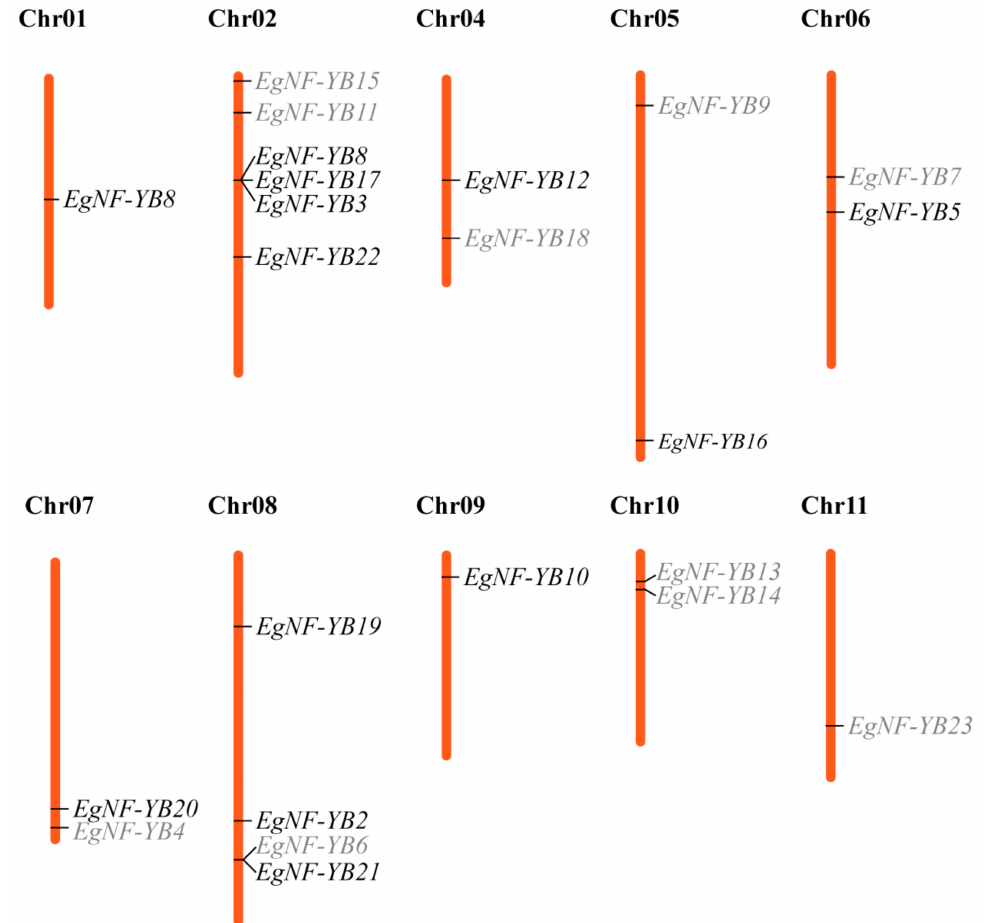
Figure 5. Chromosomal localization of EgNF-YB genes on the 11 eucalyptus chromosomes. The number of chromosomes is displayed at the top of each vertical bar. The corresponding EgNF-YB gene names are connected by a short line on the left side, and different colors represent different subfamilies. Black is the LEC-1 type, and grey is the non-LEC1